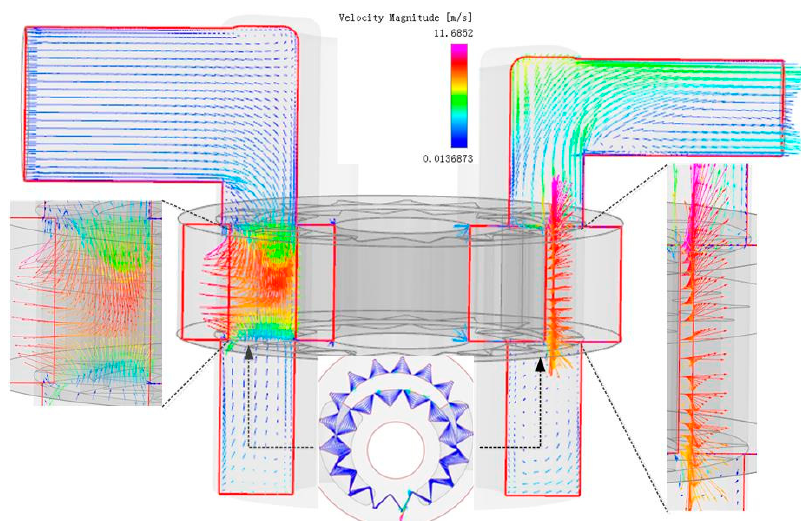
Figure 14. Velocity vector diagram of the cross-section. Processes 2020 , 8 , 269